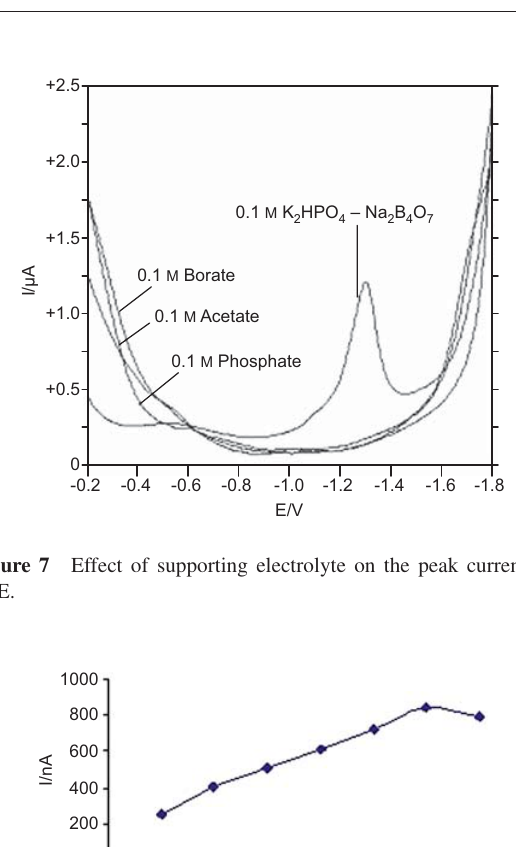
Figure 9 Effect of concentration on the peak current of EZE with the SWAdSV method (A) supporting electrolyte; (B) 66.00, (C) 99.00, (D) 323.00, (E) 446.00, (F) 596.0 ng/ml EZE (accumulation time of 15 s, accumulation potential of -0.80 mV, frequency of 15 Hz, amplitude of 25 mV, potential increment of 4 mV).